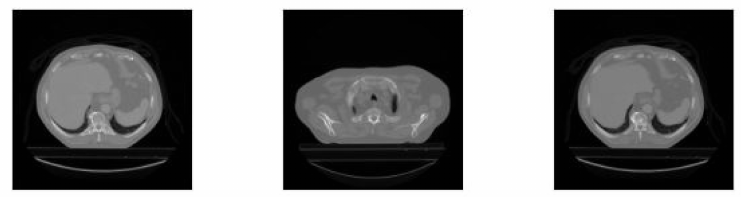
Figure 5. Example of images classified as false positive by all tested networks.